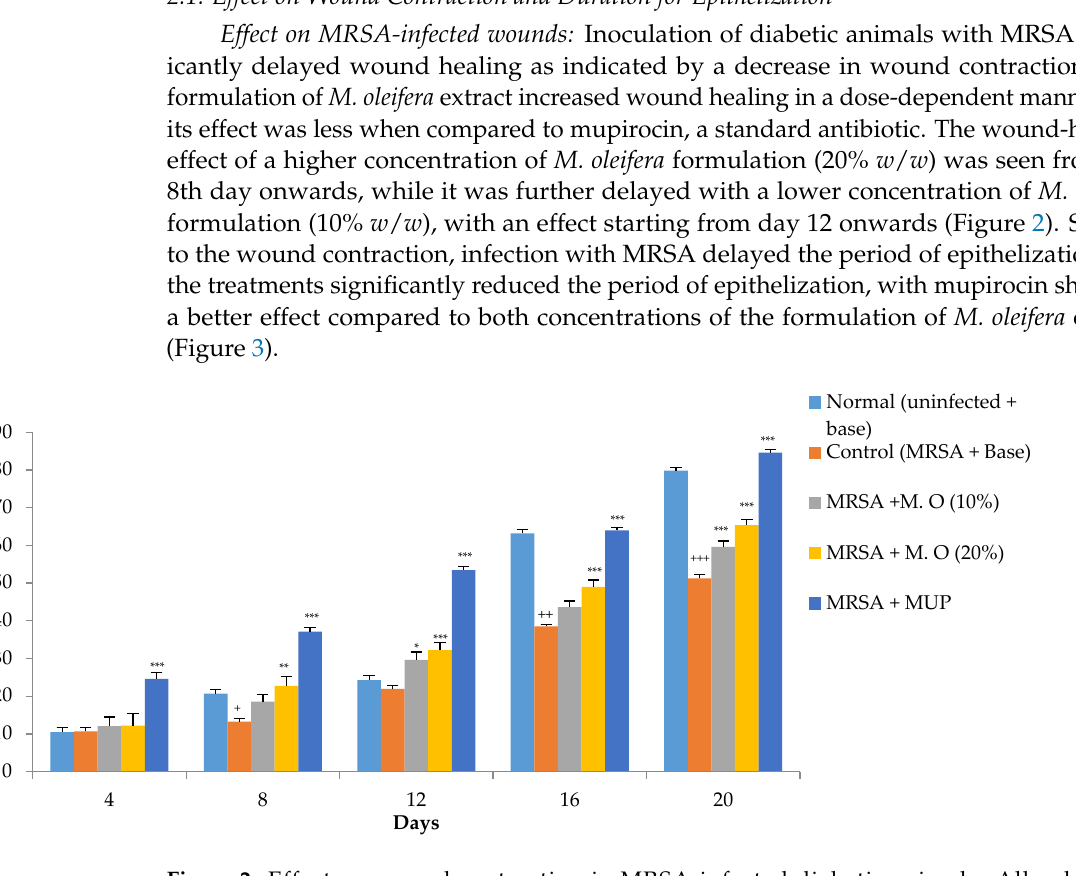
Figure 2. Effect on wound contraction in MRSA-infected diabetic animals. All values are mean ± SEM, n = 12, + p < 0.05, ++ p < 0.01, +++ p < 0.001 when compared to normal (uninfected). * p < 0.05, ** p < 0.01, *** p < 0.001 when compared to control (infected). M.O = M. oleifera leaf extract formulation, MUP = mupirocin (2% w / w ).